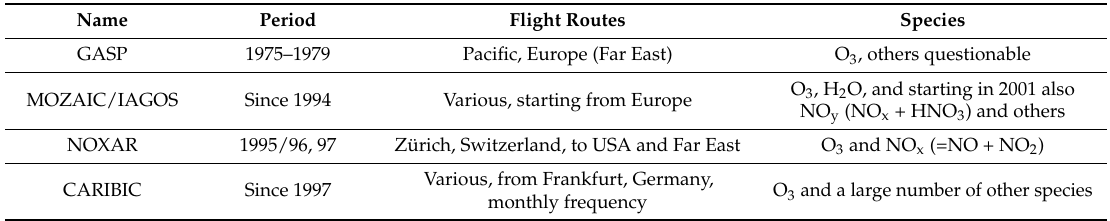
Table 1. Regular aircraft measurements relevant for ozone and reactive gases in the